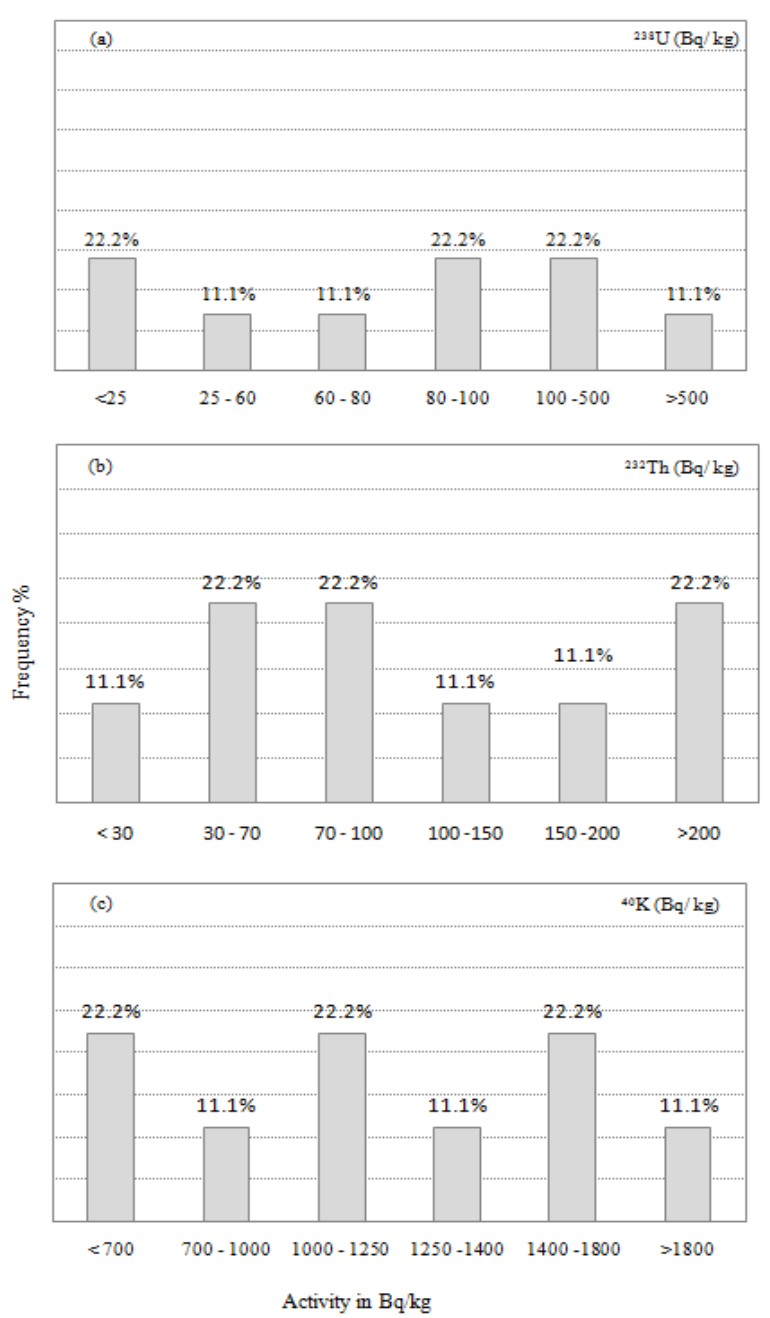
Figure 4. Frequency distributions of activity concentrations (Bq kg −1 ) for the Sol Hamed coarse- grained granite: ( a ) 238 U; ( b ) 232 Th; ( c ) 40 K.